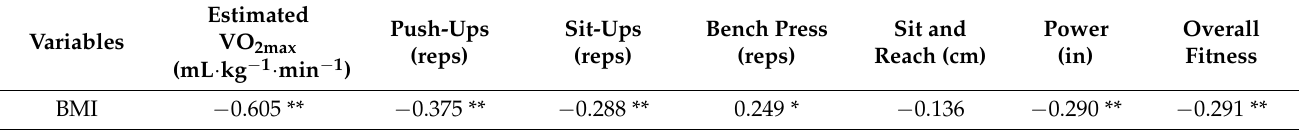
Table 7. Relationship between Fitness and BMI at Week 1.